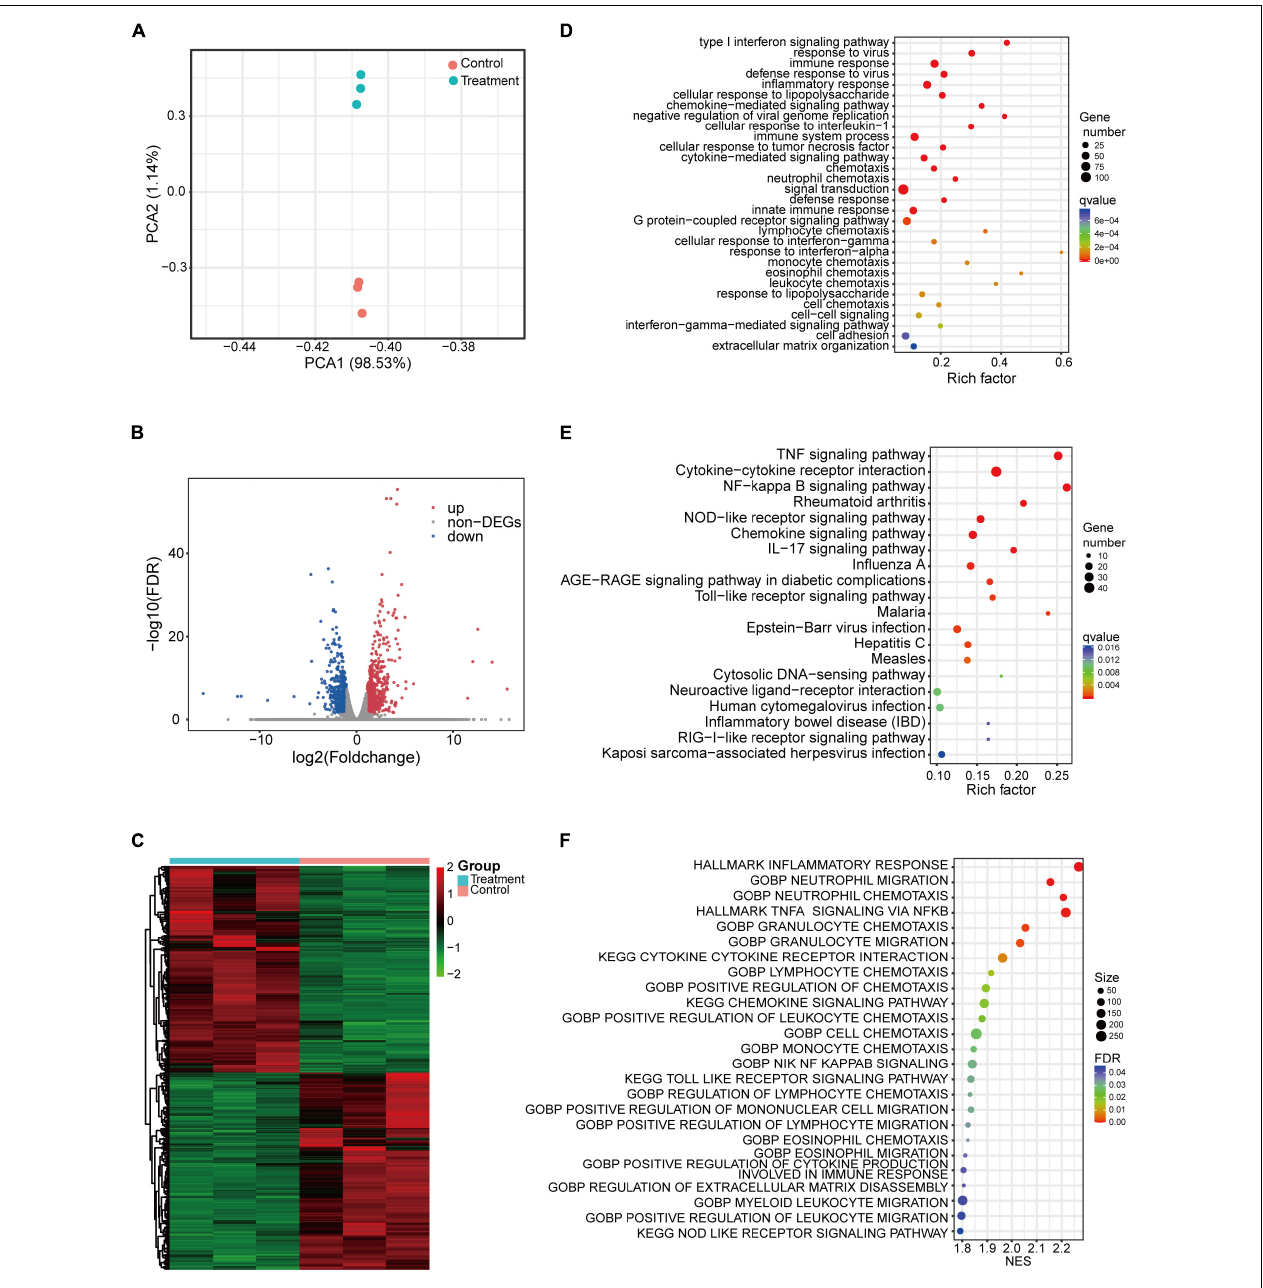
FIGURE 4 | Transcriptomic analysis of THP-1 macrophages exposed to IL-26. (A) Principal component analysis of protein-coding genes. (B) Volcano plots showing protein-coding genes from untreated and IL-26-treated macrophages, red and blue indicate the significantly upregulated and downregulated genes, respectively. (C) Heatmap of differentially expressed protein-coding genes between untreated and IL-26-treated macrophages. (D) GO enrichment analysis (biological process) of up-regulated genes. (E) Top 20 from the KEGG enrichment analysis of up-regulated genes ranked by q -value. (F) GSEA analysis of all protein-coding genes in IL-26-treated